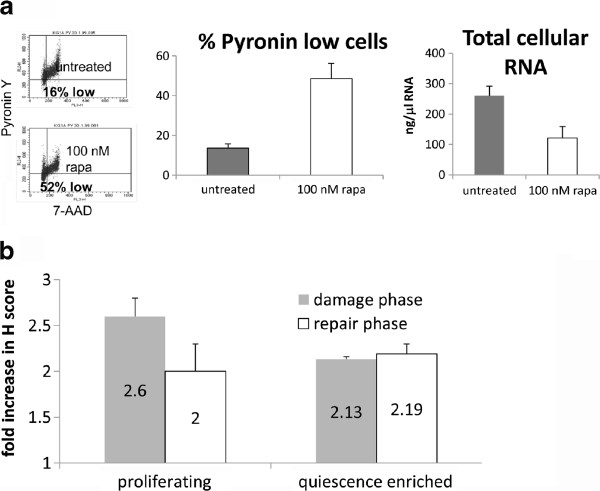
Differential resolution of γH2A.X foci in proliferating and quiescence-enriched KG1a cells. (a) Evaluation of cellular RNA content after treatment with 100nM rapamycin for 48 hours. (i) Flow cytometric dotplots indicating the percentage of cells which are low in RNA (Pyronin Y) as well as low in DNA (7-AAD); (ii) Mean and standard deviation of 5 independent assays; (iii) The total RNA content of lysed cells, measured by spectrophotometry (mean and standard deviation of 3 independent assays). (b) Proliferating and quiescence-enriched KG-1a cells were treated with 3 μM daunorubicin for 2 hours. Cells were then washed twice in ice cold RPMI at 4°C and were re-suspended in fresh culture medium and placed back in the incubator to allow a 2 hour repair period. γH2AX foci were measured by immunohistochemistry using the H score as described. Values correspond to the mean +/− standard deviation for the increase in γH2A.X foci compared with untreated controls, n = 3